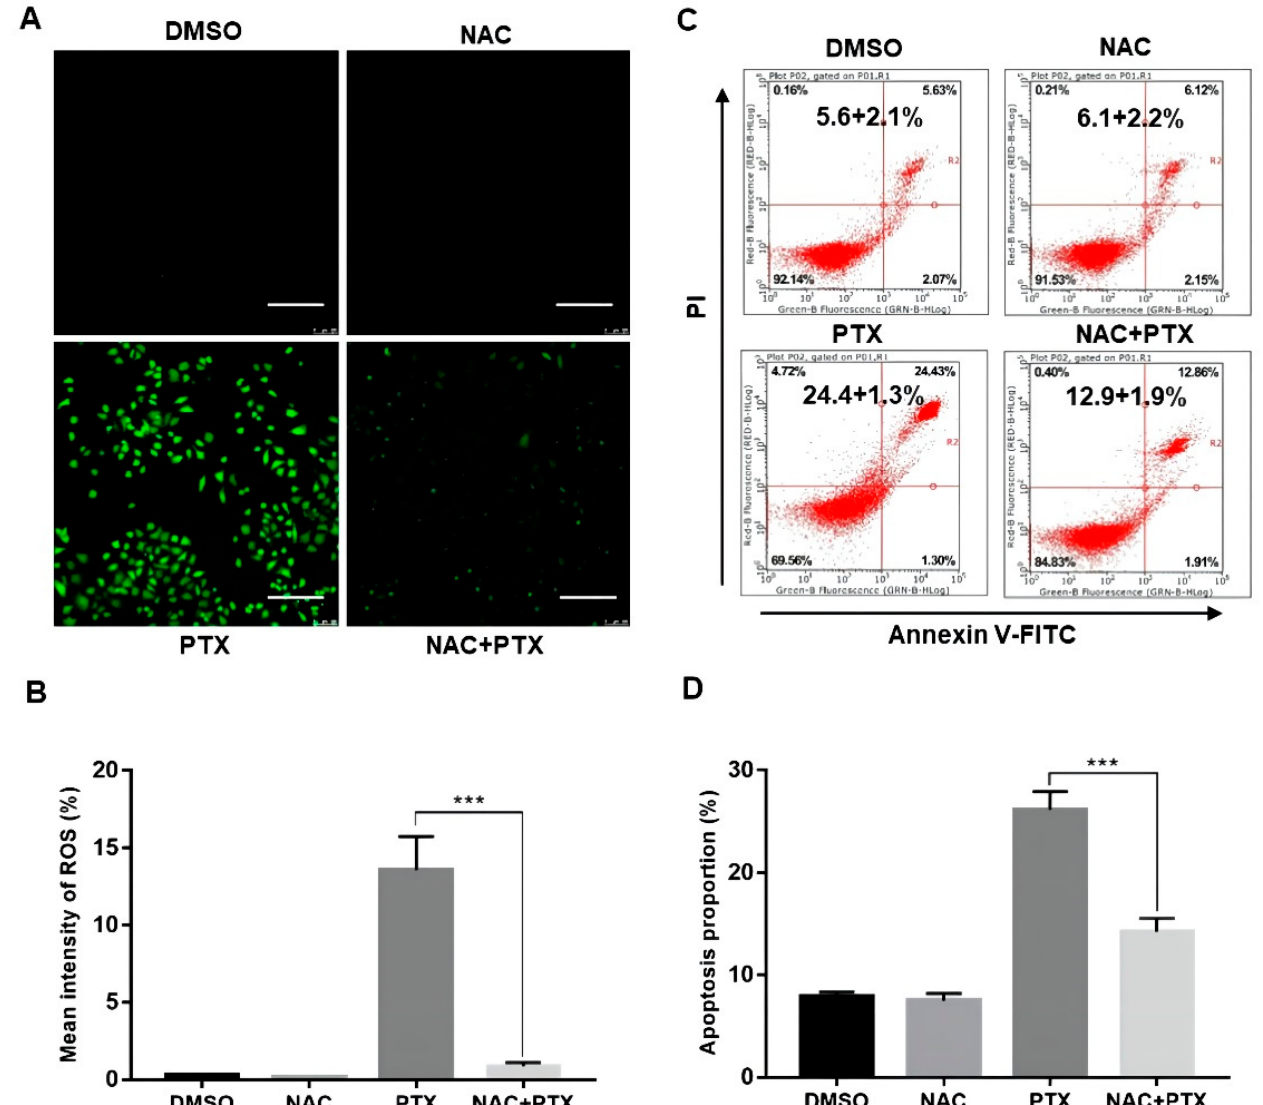
Figure 3. Paclitaxel induced apoptosis by inducing ROS generation in PC3M cells. ( A , B ) Representative images of ROS levels changes evaluated by fluorescence microscope with DCFH-DA. Scale bars = 100 µ m. ( C , D ) NAC (5 mM) inhibited the ROS generation revealed by flow cytometric analysis. Results are expressed as mean ± SD, n = 3. ***: p < 0.001.